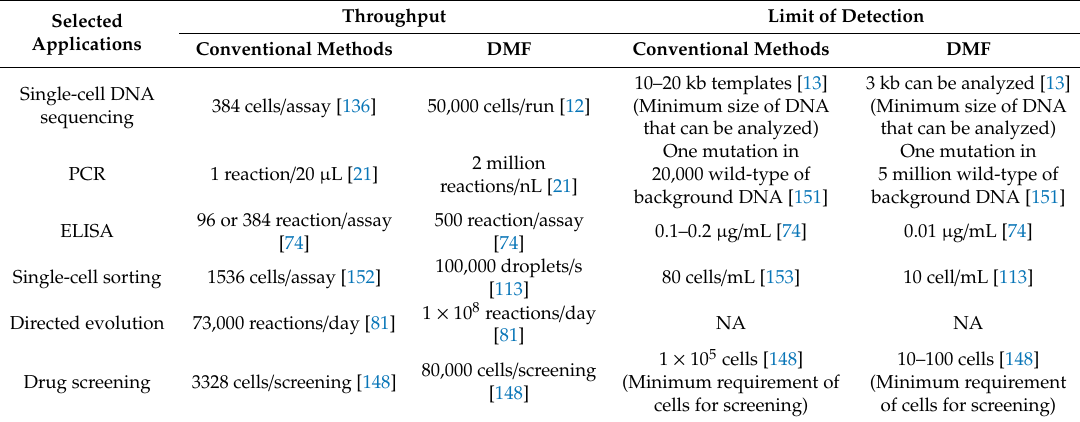
Table 1. Comparison of throughput and sensitivity of droplet-based microfluidics and selected conventional approaches.